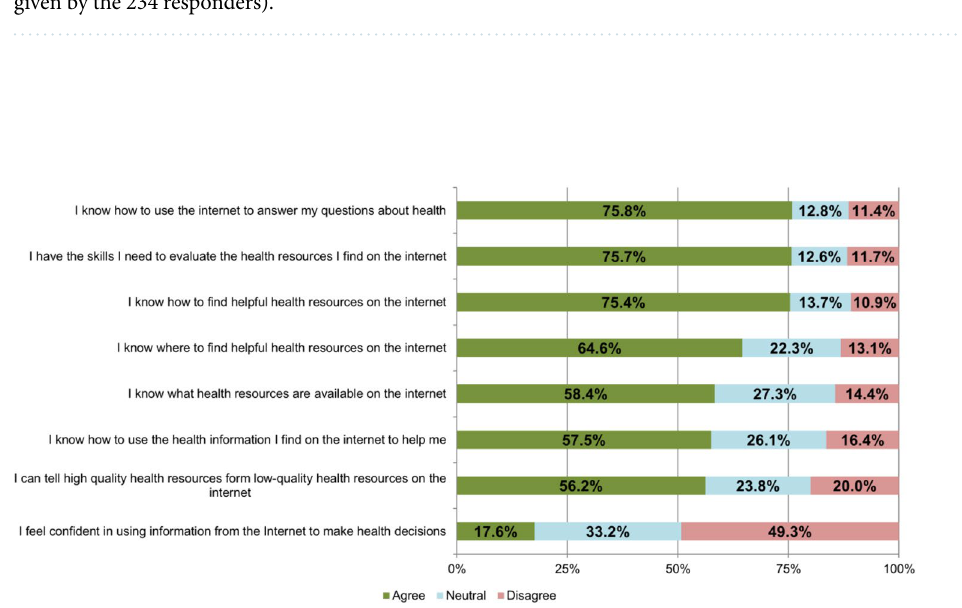
Figure 4. Results of the eHealth Literacy Scale (eHEALS) in % (answers given by the 234